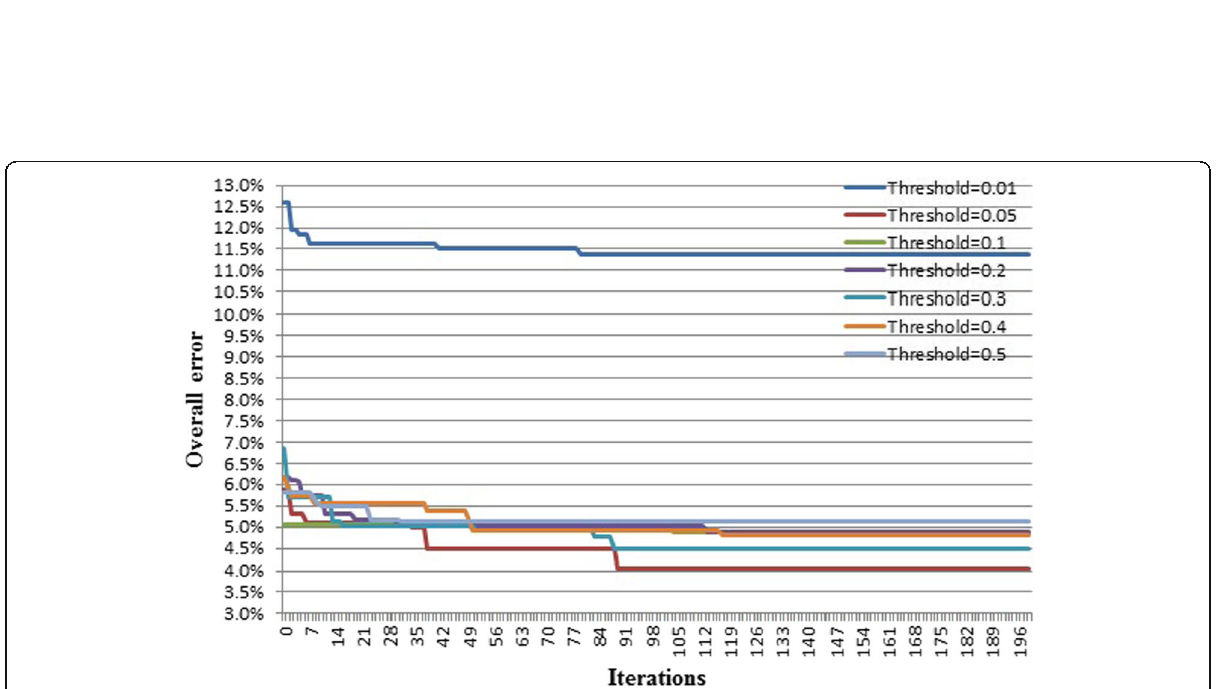
Fig. 8 The overall error variation of the GA-AdaboostLSVM classifier at different training error